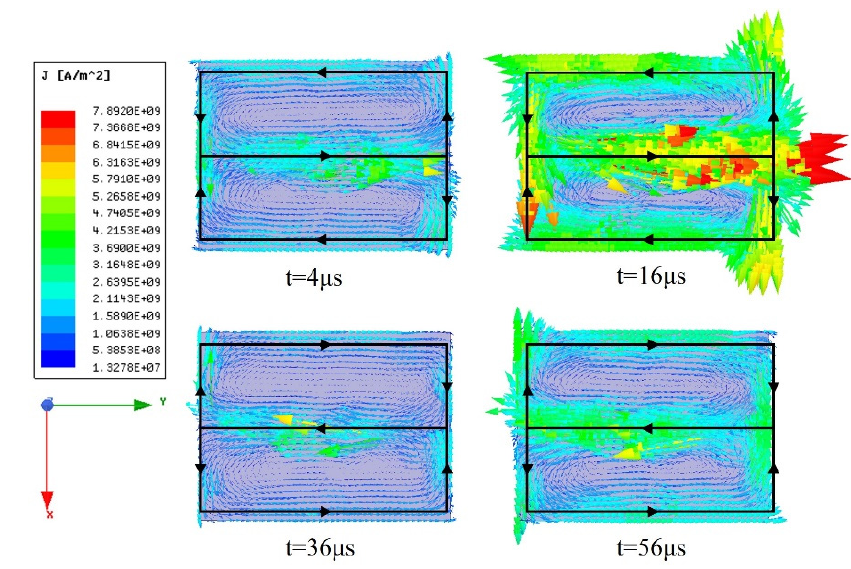
Figure 7. Induced current distribution in Al sheet.